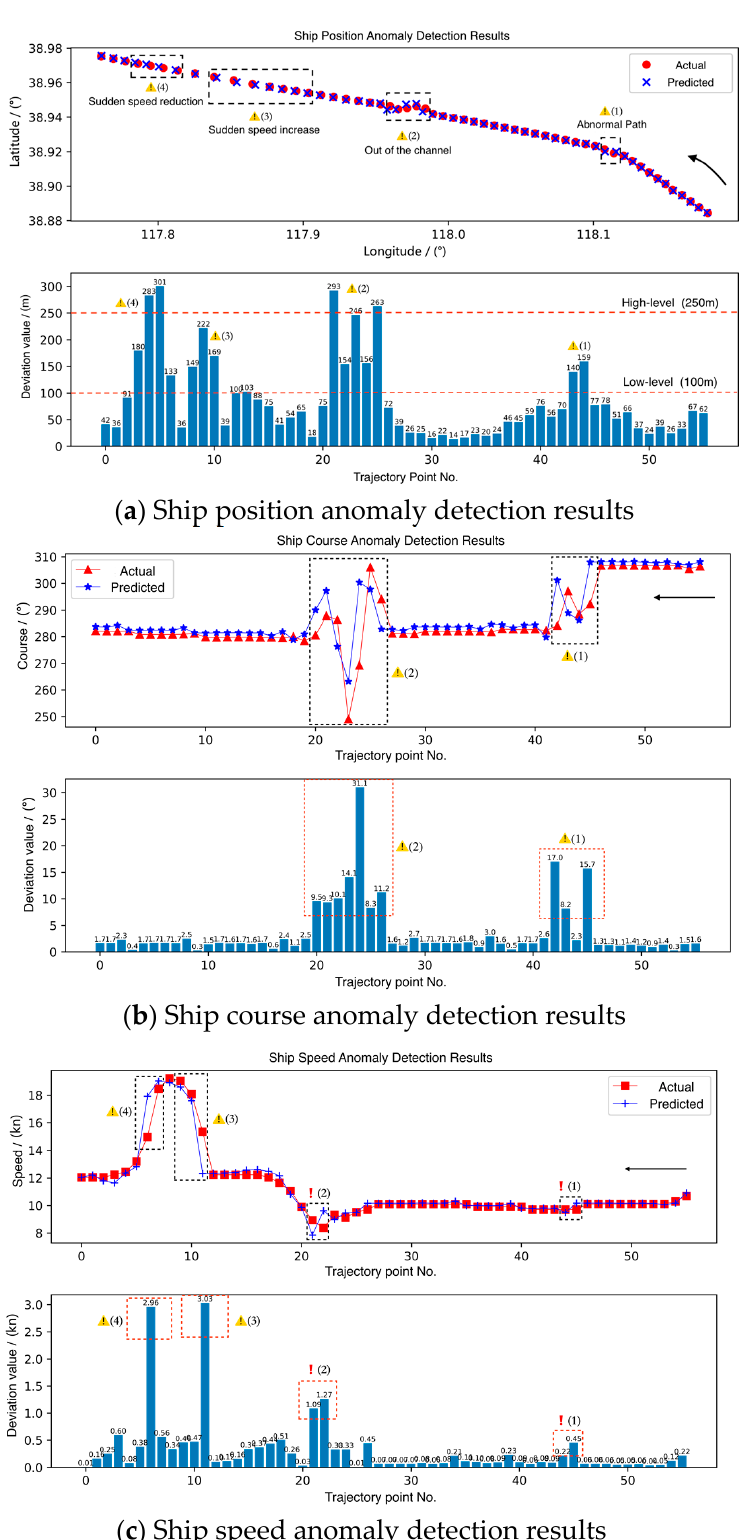
Figure 20. Detailed prediction and detection results. Table 11. Details detection results of trajectory abnormal based on